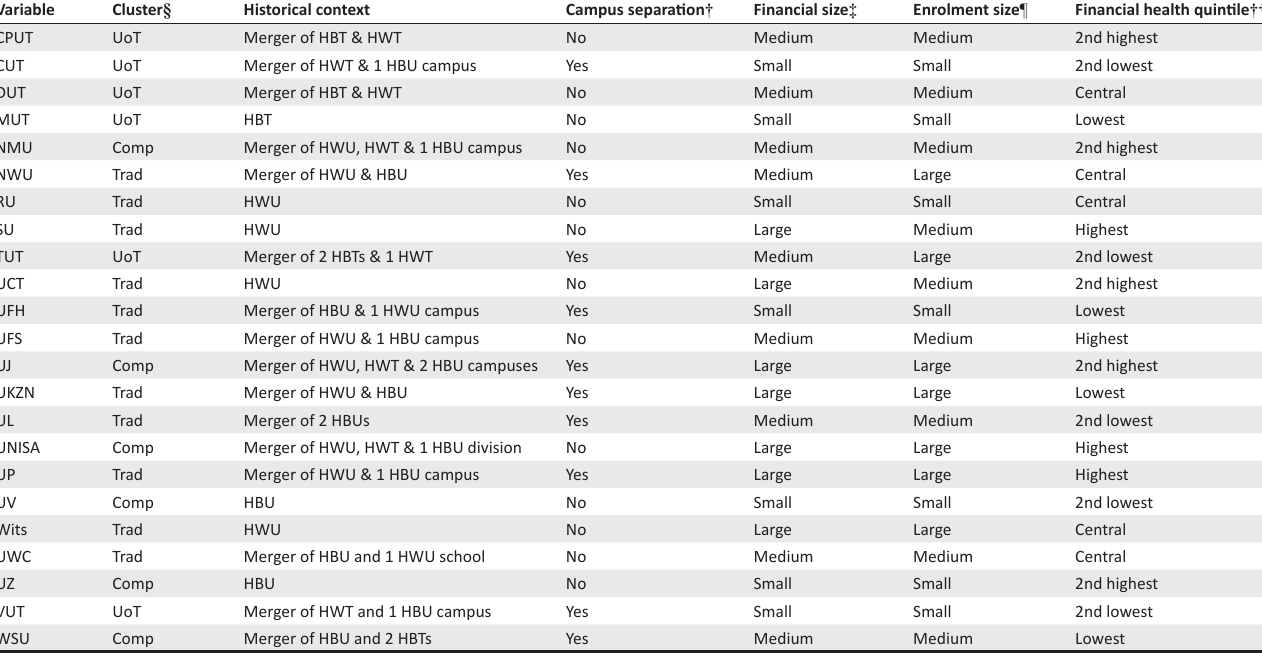
TABLE 8: Selected characteristics of the universities: Institutional details. Variable